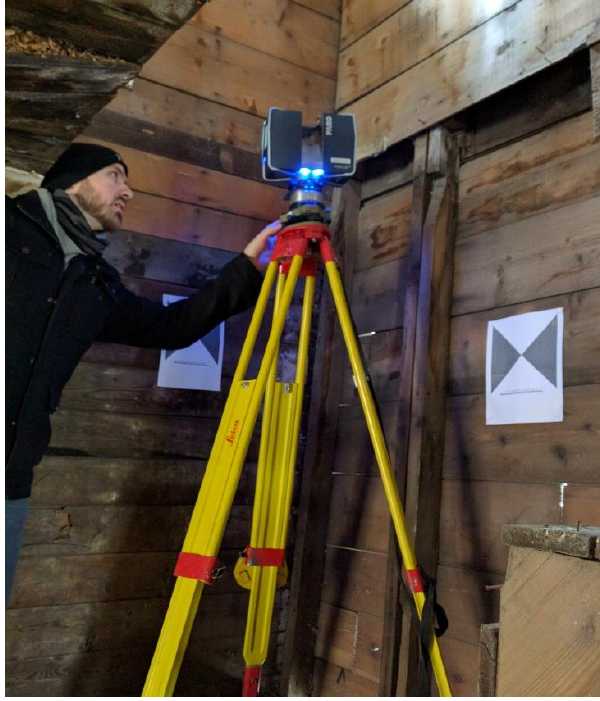
Figure 5: Scanning the interior of the laundry shop using the Faro Focus 3D scanner. Source: Peter